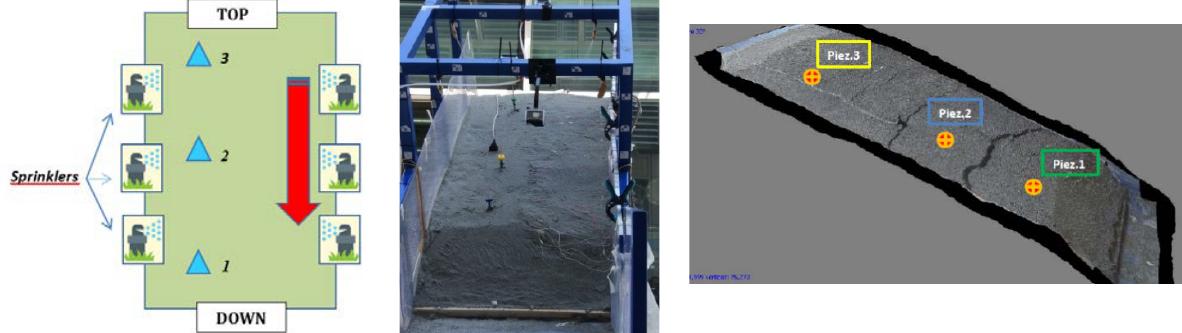
Figure 5. Positions of piezometers: layout scheme (on the left); photo of the experiment setup after inserting piezometers in the ground (on the centre); and 3D model showing how the slope model has split in three portions, each of them including a